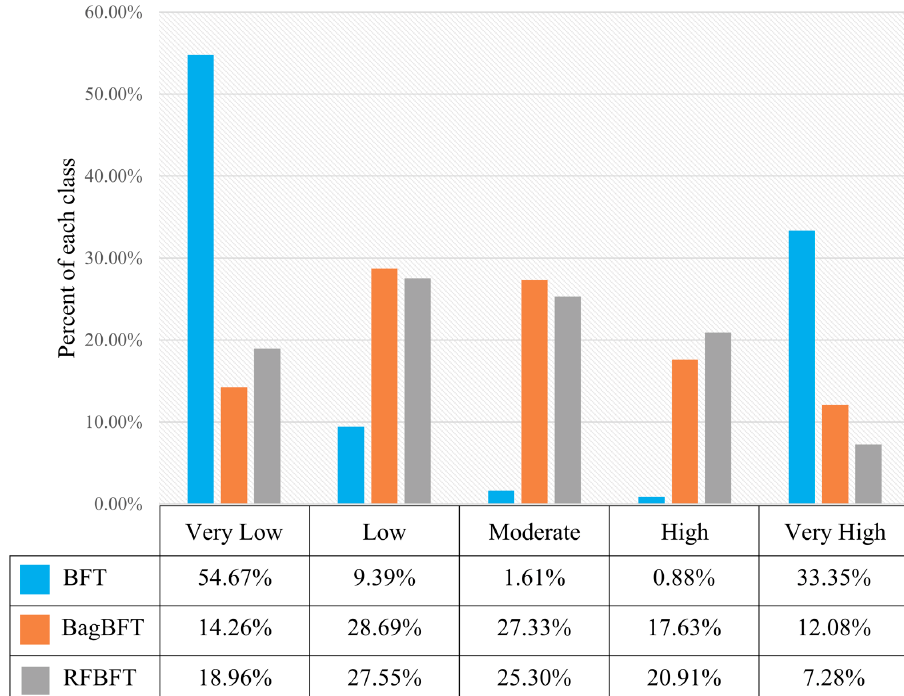
Figure 7. Distribution of landslide susceptibility zones.